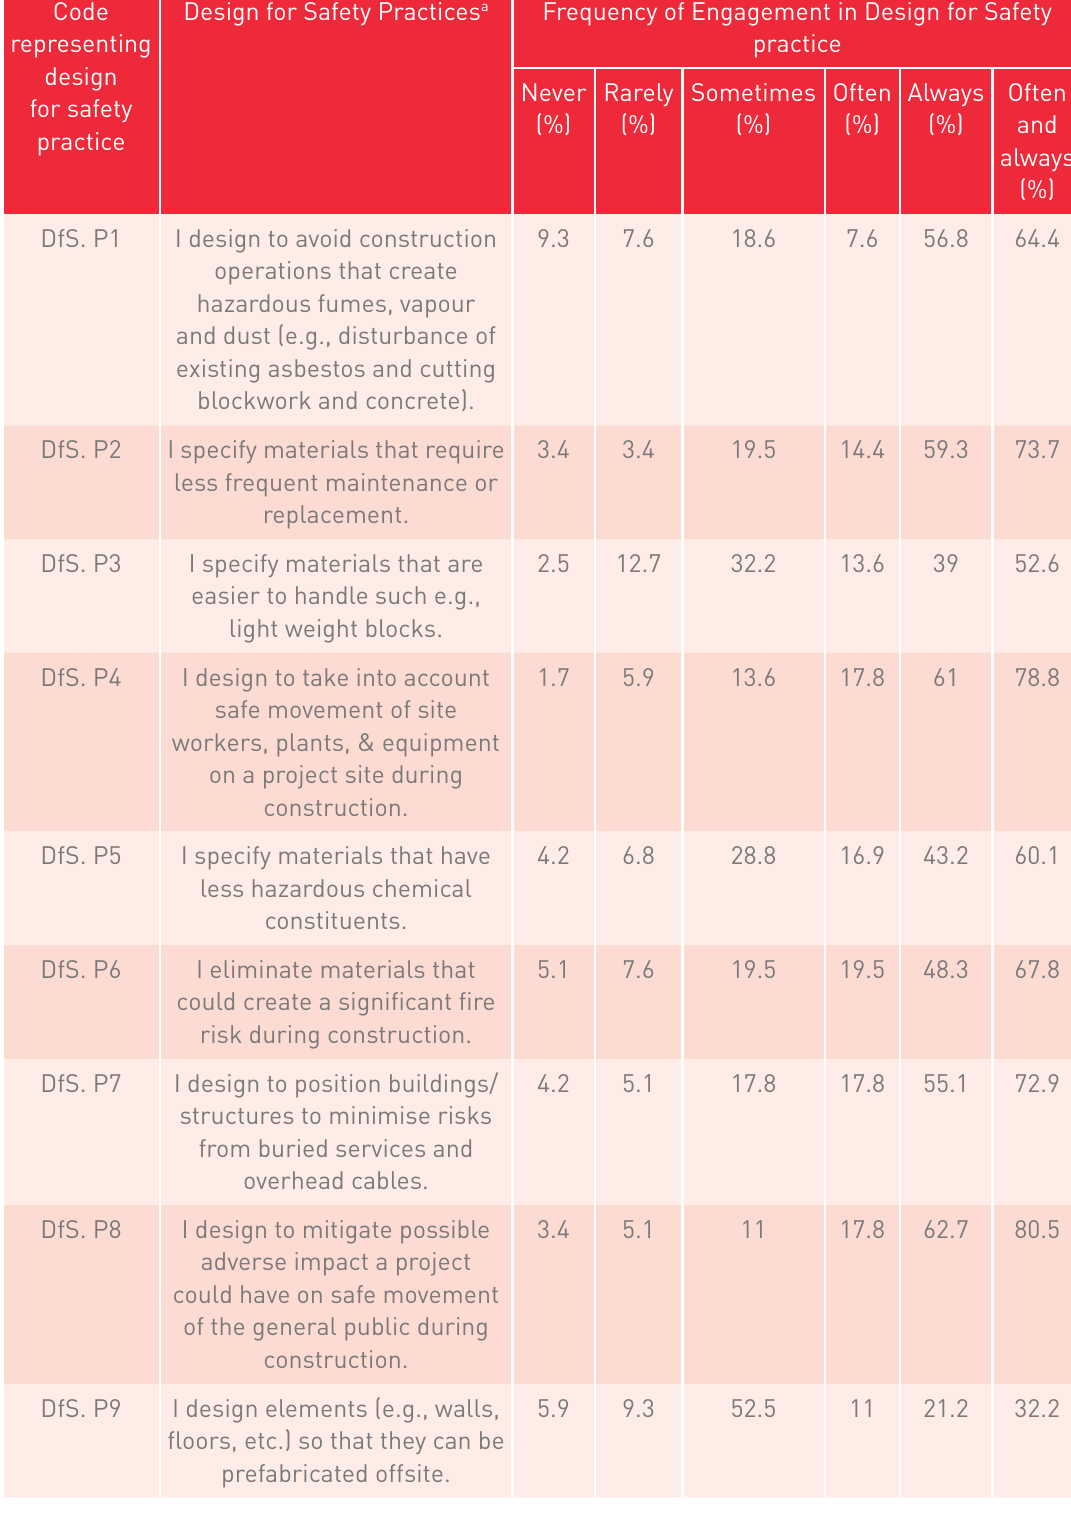
Table 6. The level of engagement of the respondents in DfS